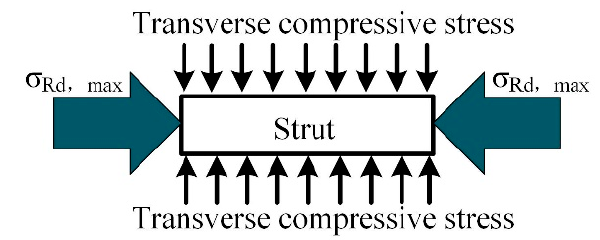
Figure 5. Concrete strut under compressive stress.